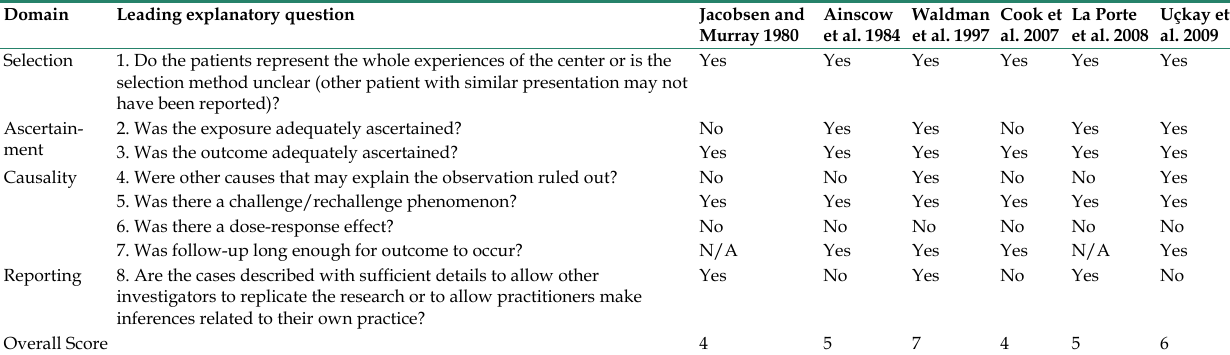
Table 1. Analysis of the methodological quality of case-series Domain